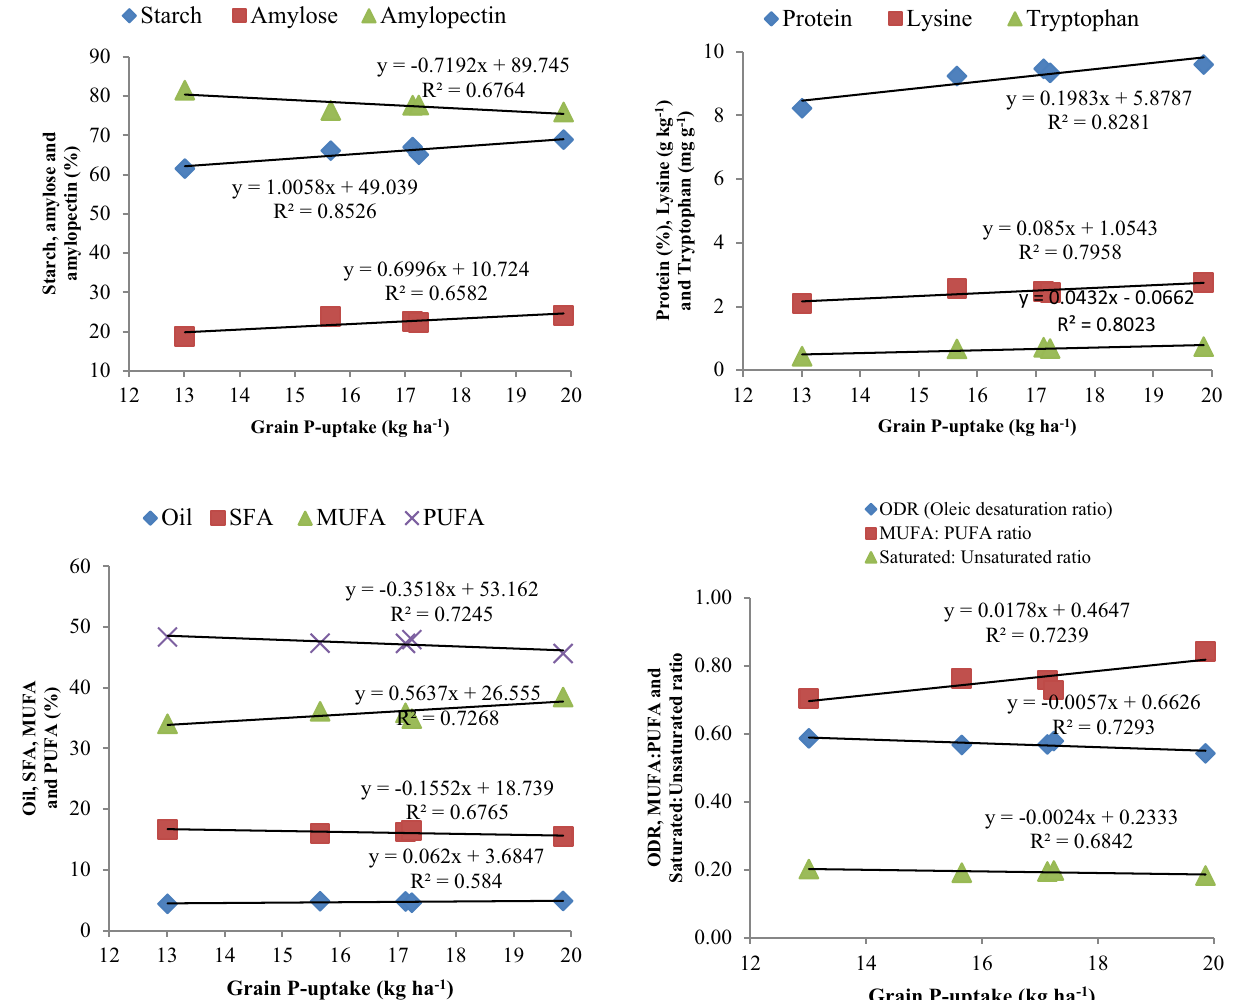
Figure 7. Correlation between grain P-uptake and quality parameters of maize under P-fertilization practices in maize under